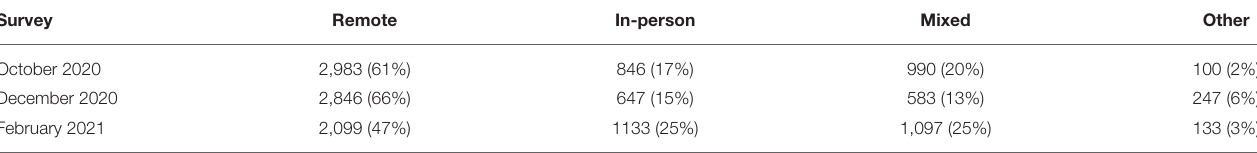
TABLE 2 | Distribution of response choices to the question: “In the past week, was your schooling taking place:”